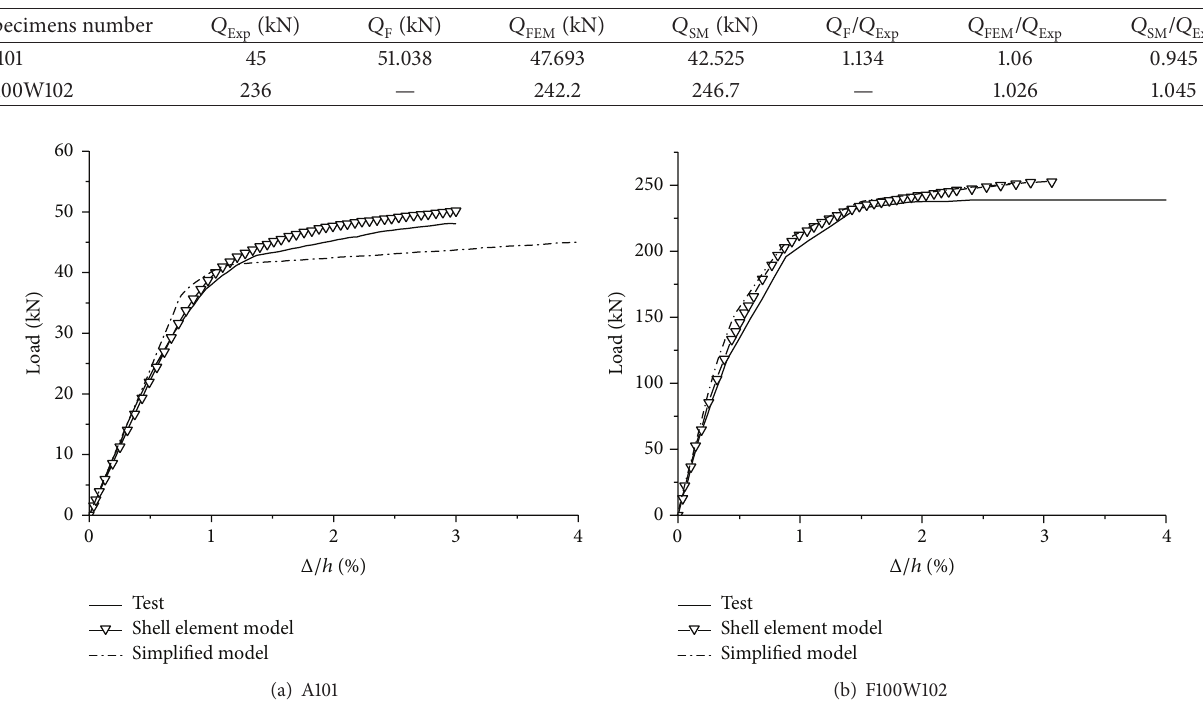
Table 5: Comparison of the strength.